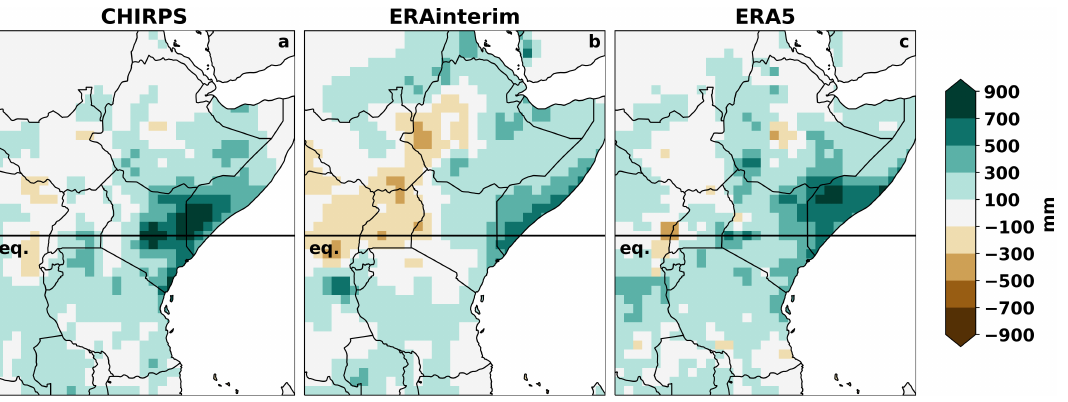
Figure 12. 1997 annual precipitation anomalies in East Africa in CHIRPS ( a ), ERA-interim ( b ) and ERA5 ( c